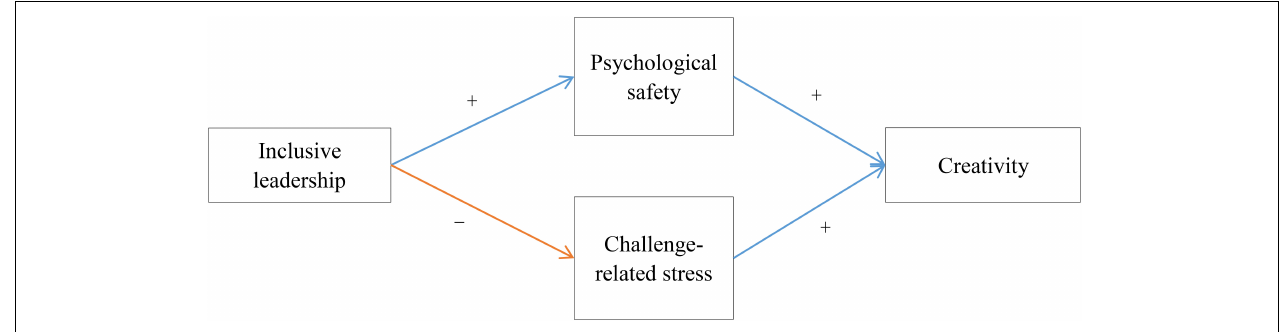
FIGURE 1 | Theoretical